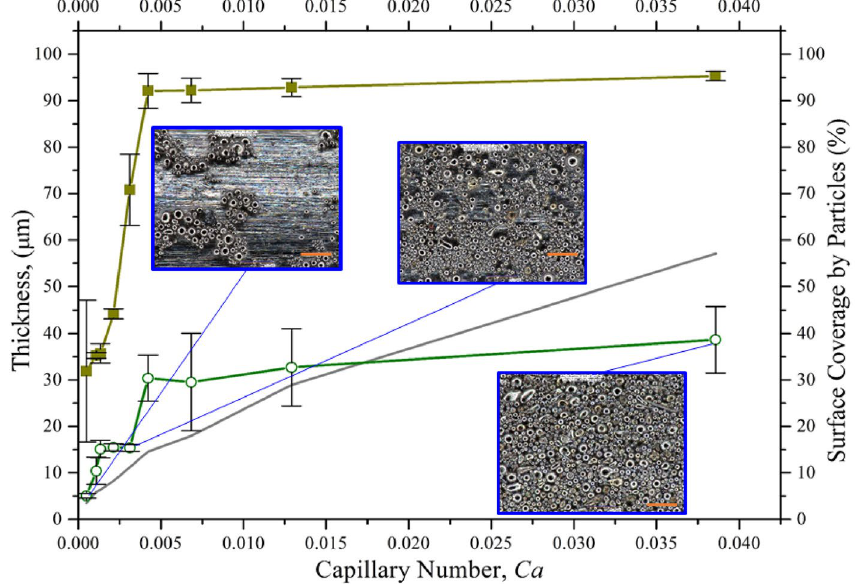
Figure 8. Surface coverage (%) and particle laden film thickness as a function of capillary number. The circular hollow dotted point represents the film thickness, and the rectangular solid dotted point represents the surface coverage by particles. 50 µm scale